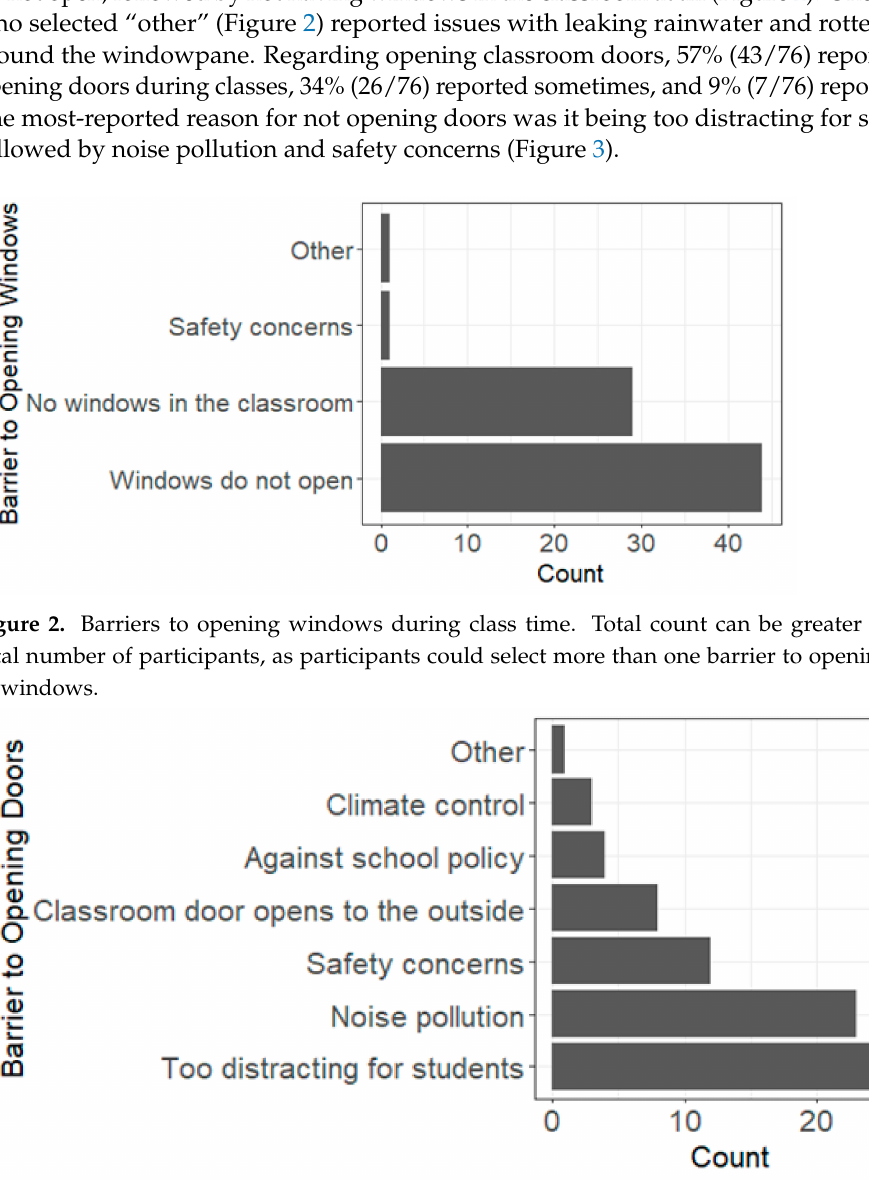
Figure 3. Barriers to opening doors during class time. Total count can be greater than the total number of participants, as participants could select more than one barrier to opening doors or